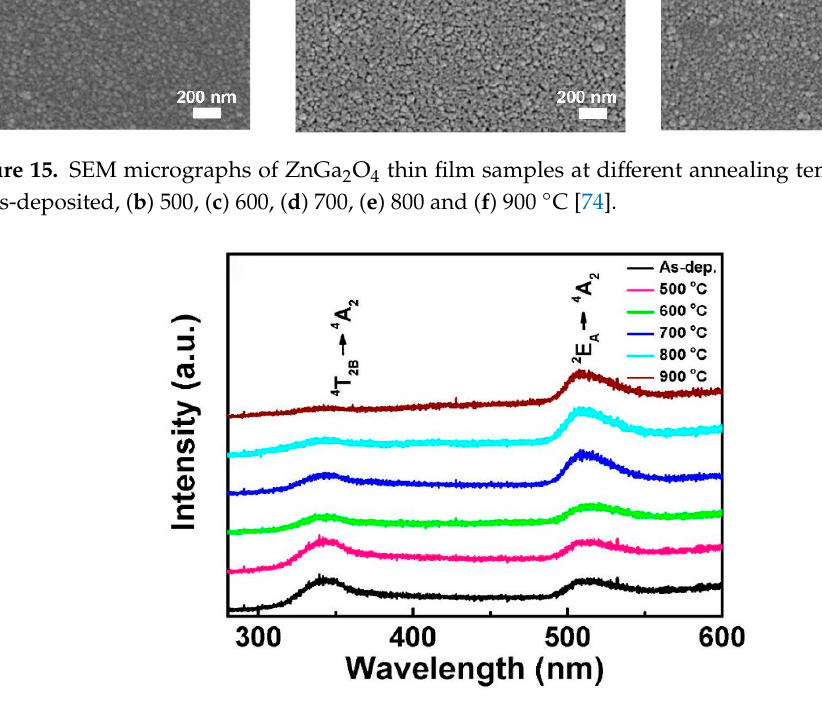
Table 5. Cathodoluminescence (CL) peaks and crystalline orientations with different process parameters for mist chemical vapor deposition (CVD) and metal-organic CVD (MOCVD). Process Method